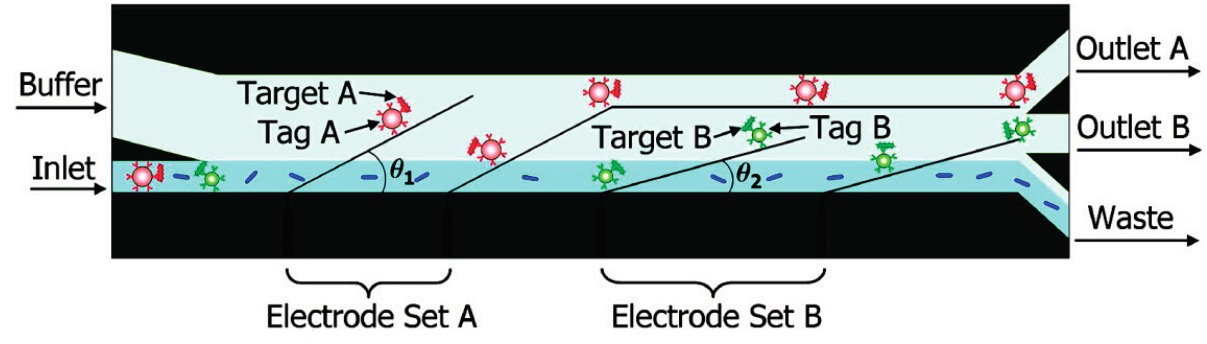
Figure 10. Schematic diagram of the lateral DEP microseparator